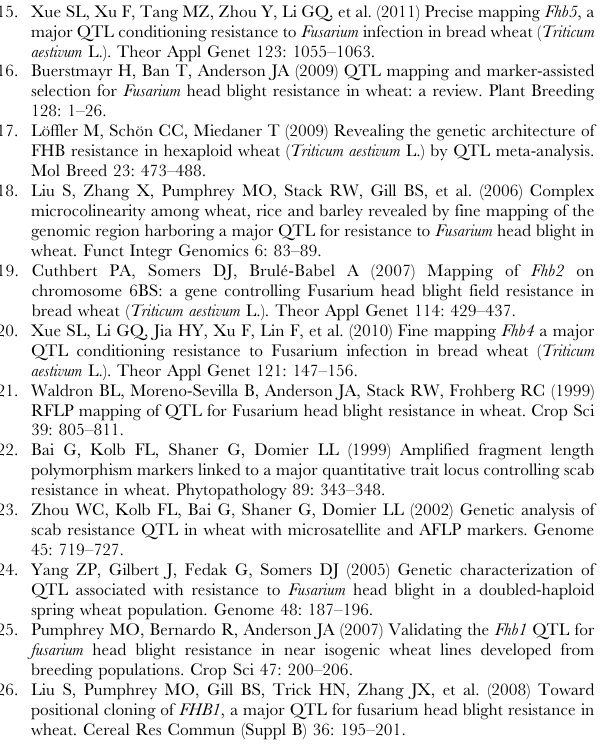
Figure S1 Hierarchical clustering (UPGMA) of screened accessions based on a Manhattan dissimilarity matrix using five FHB-related traits. Blue line means negative control, and red line indicates positive control. Figure S2 Association studies of five FHB-related traits with molecular markers in the 3.1-Mb genomic region. (a) Dot plots of compressed mixed linear model (MLM) for percentage of diseased spikelets (PDS). Negative log 10 -transformed P values in a sequenced contig ( ctg954 ) of 3.1-Mb are plotted against position along the contig. Blue horizontal dashed line indicates the chromosome-region significance threshold. (b) Quantile-quantile plot of compressed MLM for PDS. (c) Dot plots of compressed MLM for disease severity (DS), as in a. (d) Quantile-quantile plot of compressed MLM for DS. (e) Dot plots of compressed MLM for disease index (DI), as in a. (f) Quantile- quantile plot of compressed MLM for DI. Figure S3 Comparison of allelic effects of four loci significantly associated with FHB-related traits NDS (a), LDR (b), DS (c) and DI (d). Table S1 FHB-related traits of controls in different environ- ments. Table S2 Correlation analyses of five FHB-related traits.